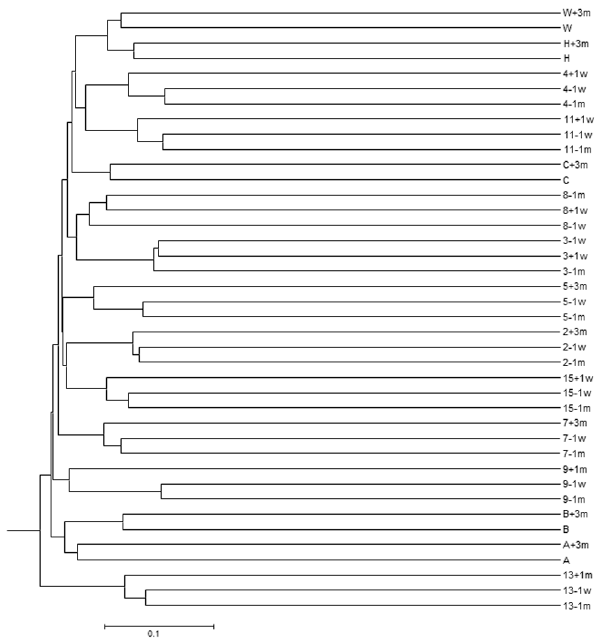
Figure 1. Comparison of the composition of the fecal microbial communities of each sample using the Jaccard similarity coefficient. Distances between communities, based on the presence and absence of 16S rRNA sequences, were calculated with the Jaccard coefficient (jclass) within Mothur and clustered using the UPGMA algorithim. The first numeral/letter (subjects that underwent colonos- copy/subjects who did not) corresponds to the subject, the last numeral indicates when the sample was obtained. For subjects who underwent colonoscopy: 2 1m, 2 1w, sample obtained one month, one week pre- colonoscopy, + 1w, + 1m, + 3m, sample obtained 1 week, one month, or 3–6 months post-colonoscopy, respectively. For subjects who did not undergo colonoscopy: + 3m, sample obtained 3–6 months after the first sample.